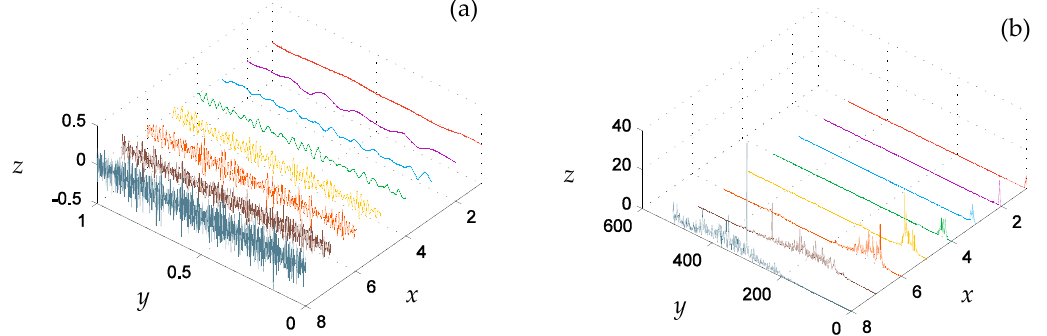
Figure 15. Signal DTCWT component of ( a ) time domain and ( b ) frequency domain. Each x axis tick in the figure means a DTCWT component where the blue grey line indicates the w 1 ( t ), the brown line indicates the w 2 ( t ), the orange line indicates the w 3 ( t ), the yellow line indicates the w 4 ( t ), the green line indicates the w 5 ( t ), the blue line indicates the w 6 ( t ), the purple line indicates the w 7 ( t ), and the red line indicates the c 7 ( t ).